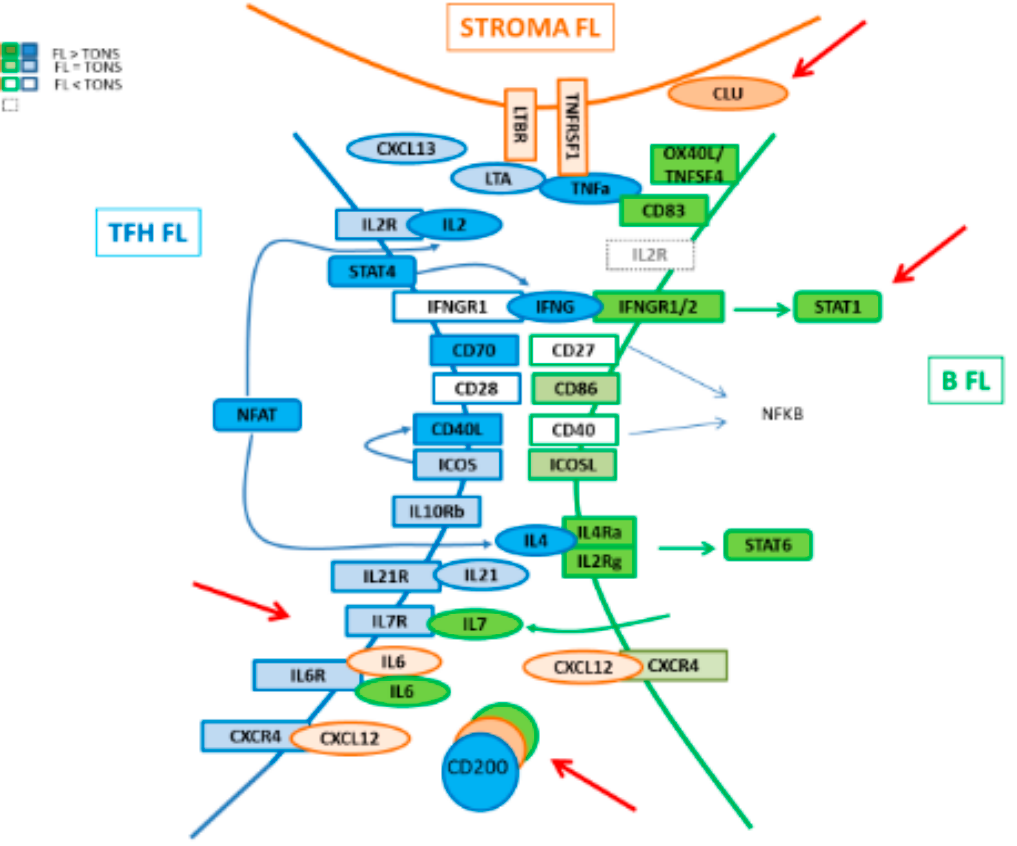
Figure 8. Schematic representation of interactions in FL niche.